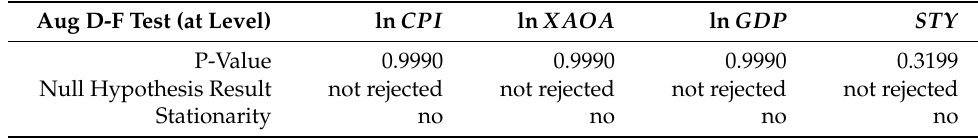
Table A2. ADF Unit Root Test at